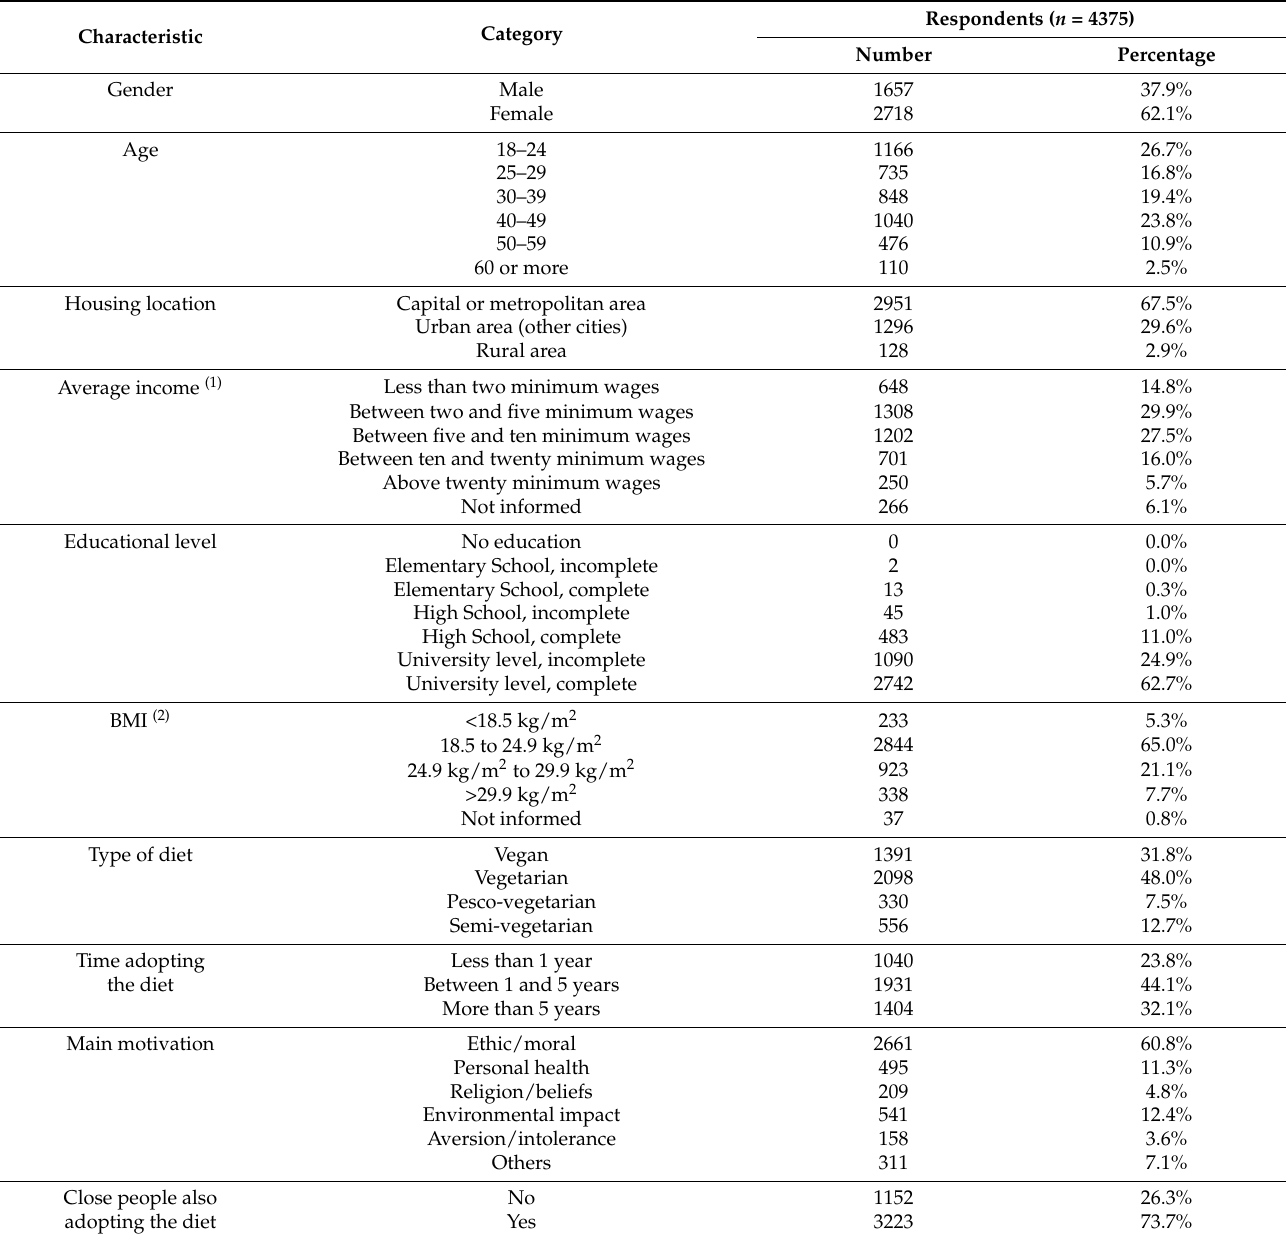
Table 1. Characteristics of the